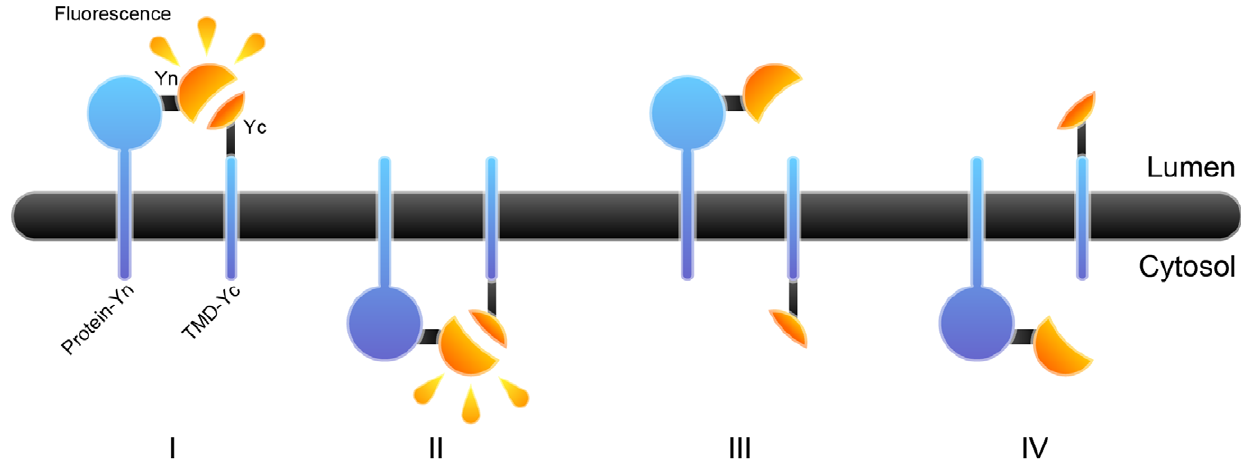
Figure 1. Illustrations of the principle of GO-PROMTO. Fluorescent complementation occurs when the two complementary domains of split YFP (Yn and Yc) fused to the test protein and TMD are present on the same side of the membrane (I and II), whereas no fluorescence occurs if they are on the opposite sides of the membrane (III and IV).